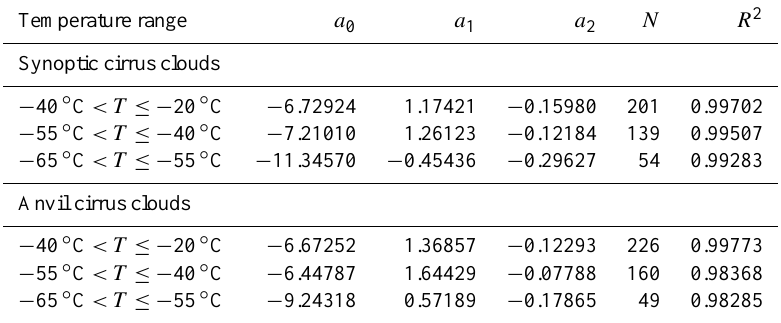
Table 1. Polynomial curve fits of the form ln m = a 0 + a 1 ln D + a 2 ( ln D) 2 for synoptic and anvil cirrus clouds sampled during SPARTICUS, where m is in grams and D is in cm. The only exception is for synoptic cirrus between − 20 and − 40 ◦ C, where SCPP data were used in lieu of SPARTICUS data, as shown in Fig. 3. The number of m - D samples is given by N , along with the coefficient of determination ( R 2 ) of the curve fit. See Sect. 3 for details.